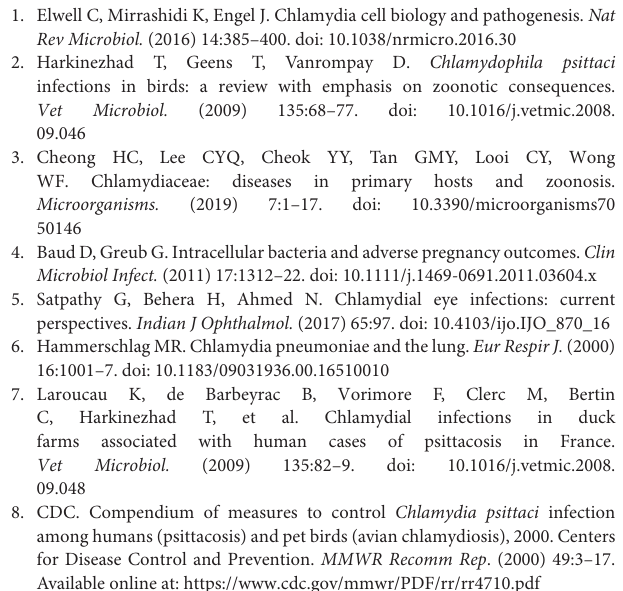
Supplementary Figure 3 | Kinetics of the number of DCs in the mouse lung before and during the first days of C. psittaci infection in WT, C3 − / − and C3aR − / − × C5aR1 − / − mice. Amount of DCs in the lung immediately before and during C.ps. infection. Lung CD11c + -cells were purified by magnetic bead separation.